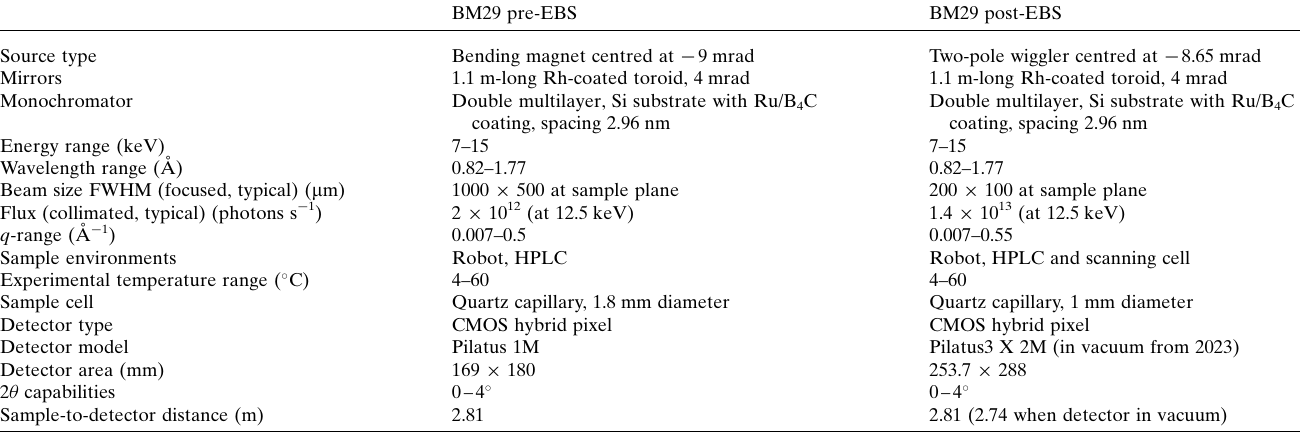
Table 1 BM29 beamline schematics pre- and post-EBS upgrade.